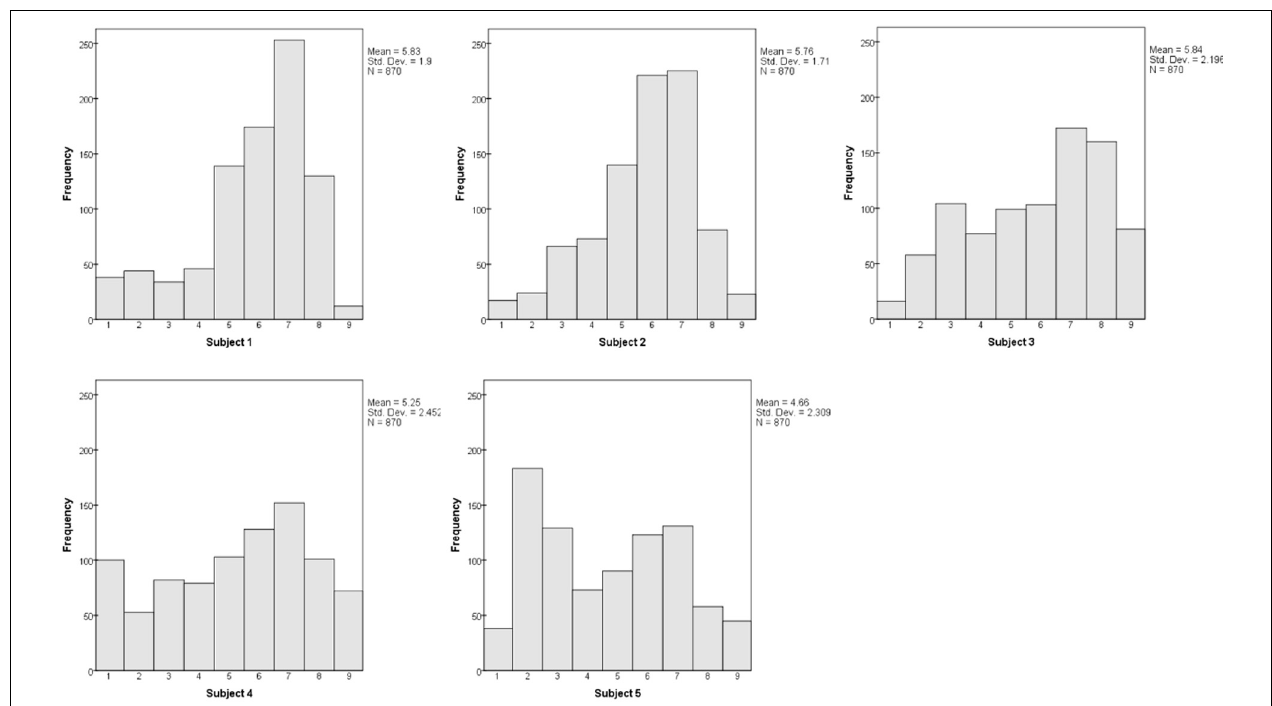
FIGURE 7 | Distributions of dissimilarity judgments from each